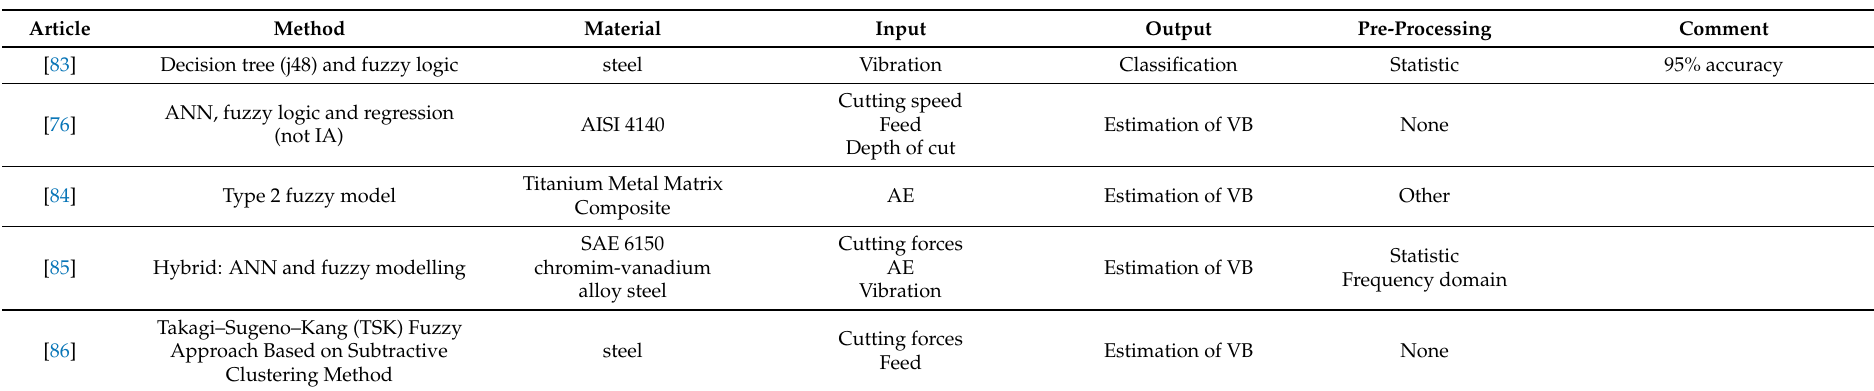
Table A2. General summary of fuzzy logic related